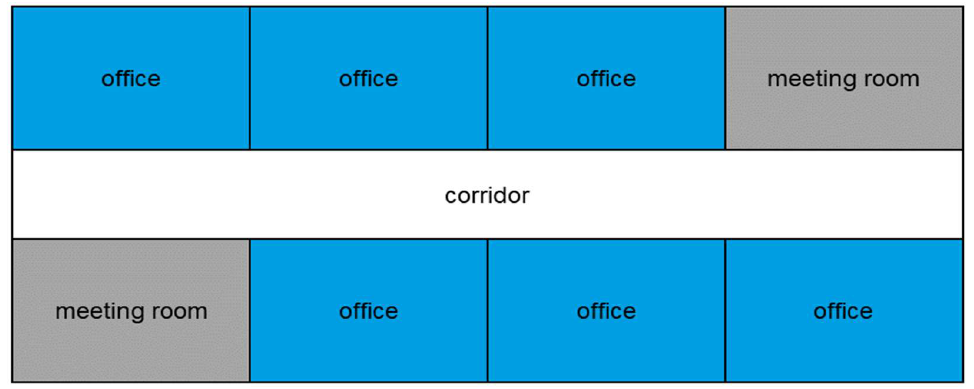
Figure 3. Standard ground floor of the office building (own representation, data from [15]).